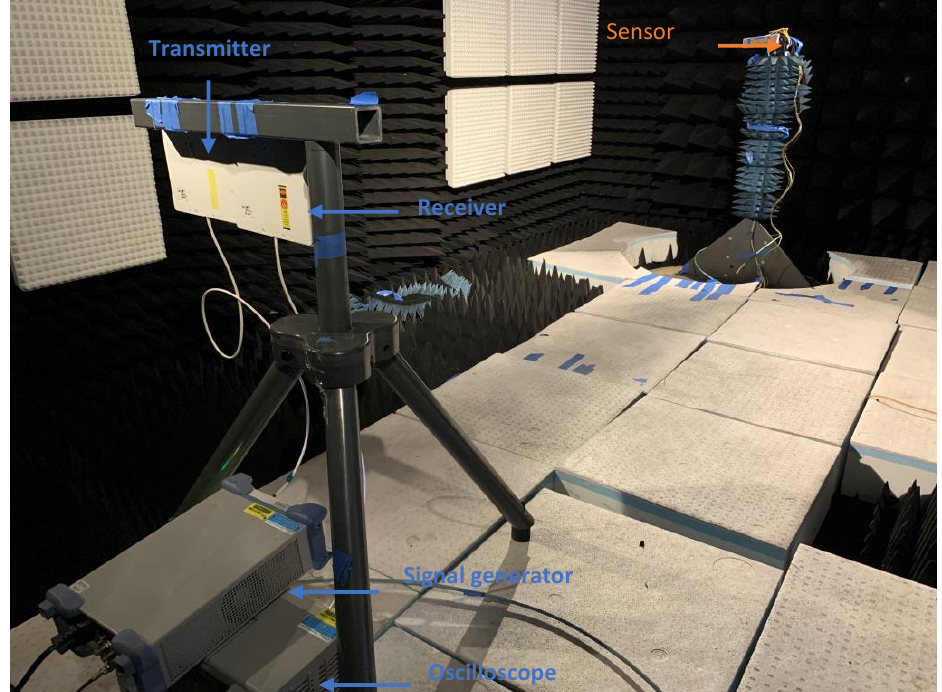
Figure 7. Measurement setup in an anechoic chamber for studying power at the receiver end as a function of sensor distance. Both the Signal generator and oscilloscope are controlled via LabVIEW from a PC placed outside the chamber.